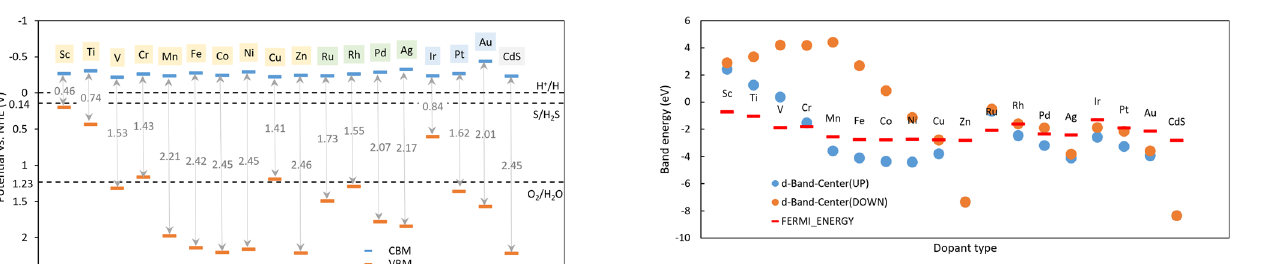
Fig. 5 Calculated spin-polarized d -band centers relative to the Fermi level for TM@CdS structures. Data are available in